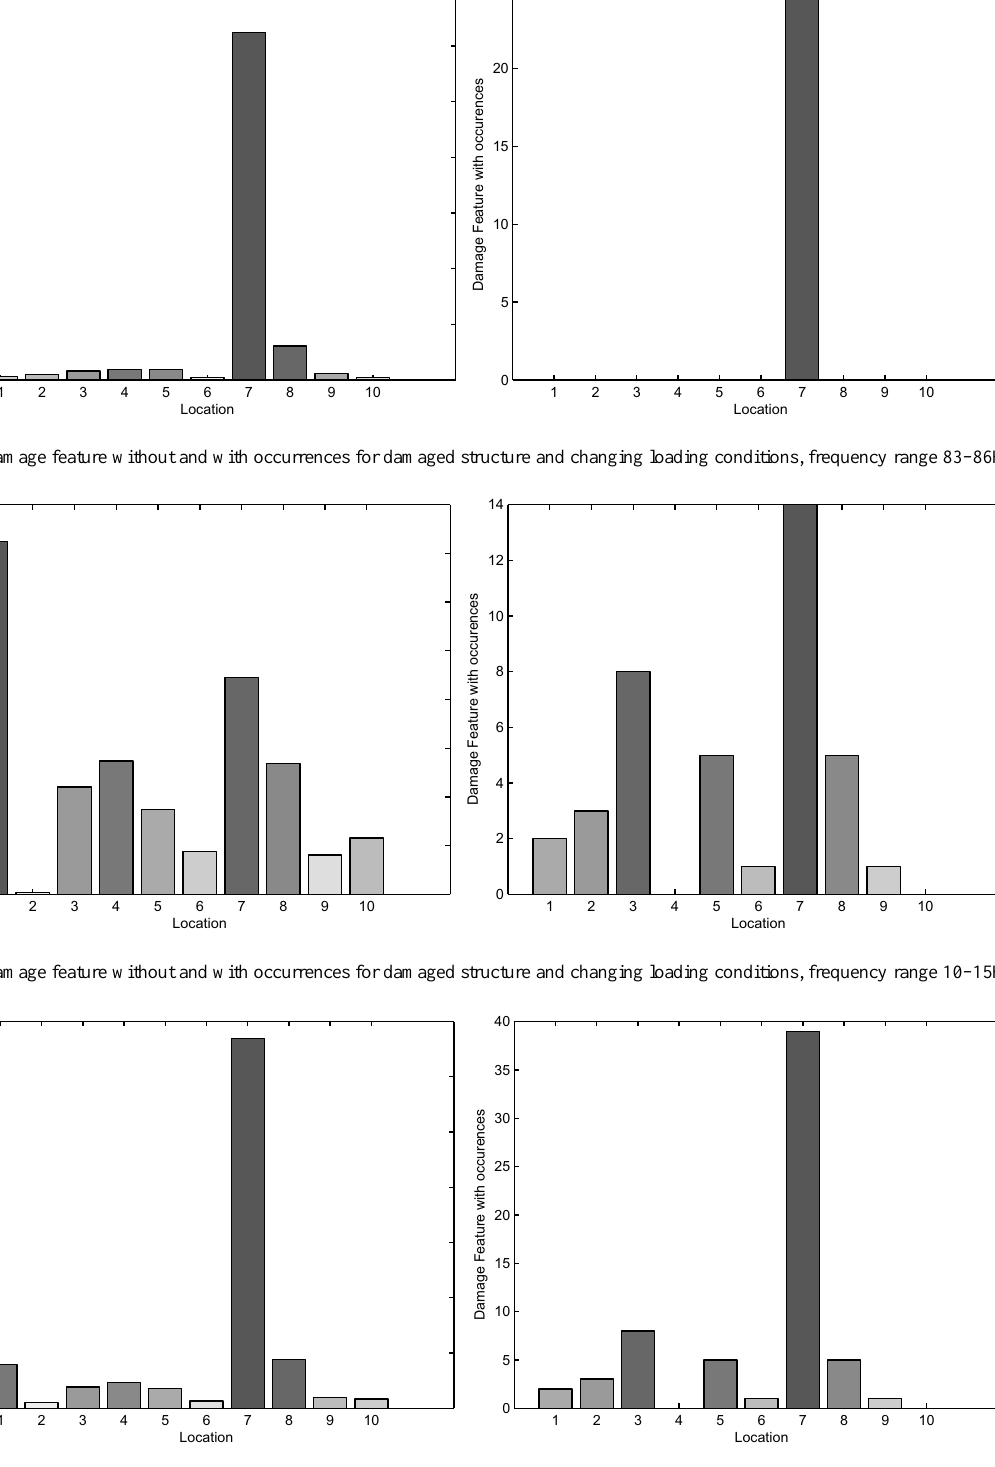
Fig. 36. Damage feature without and with occurrences for damaged structure and changing loading conditions with frequency